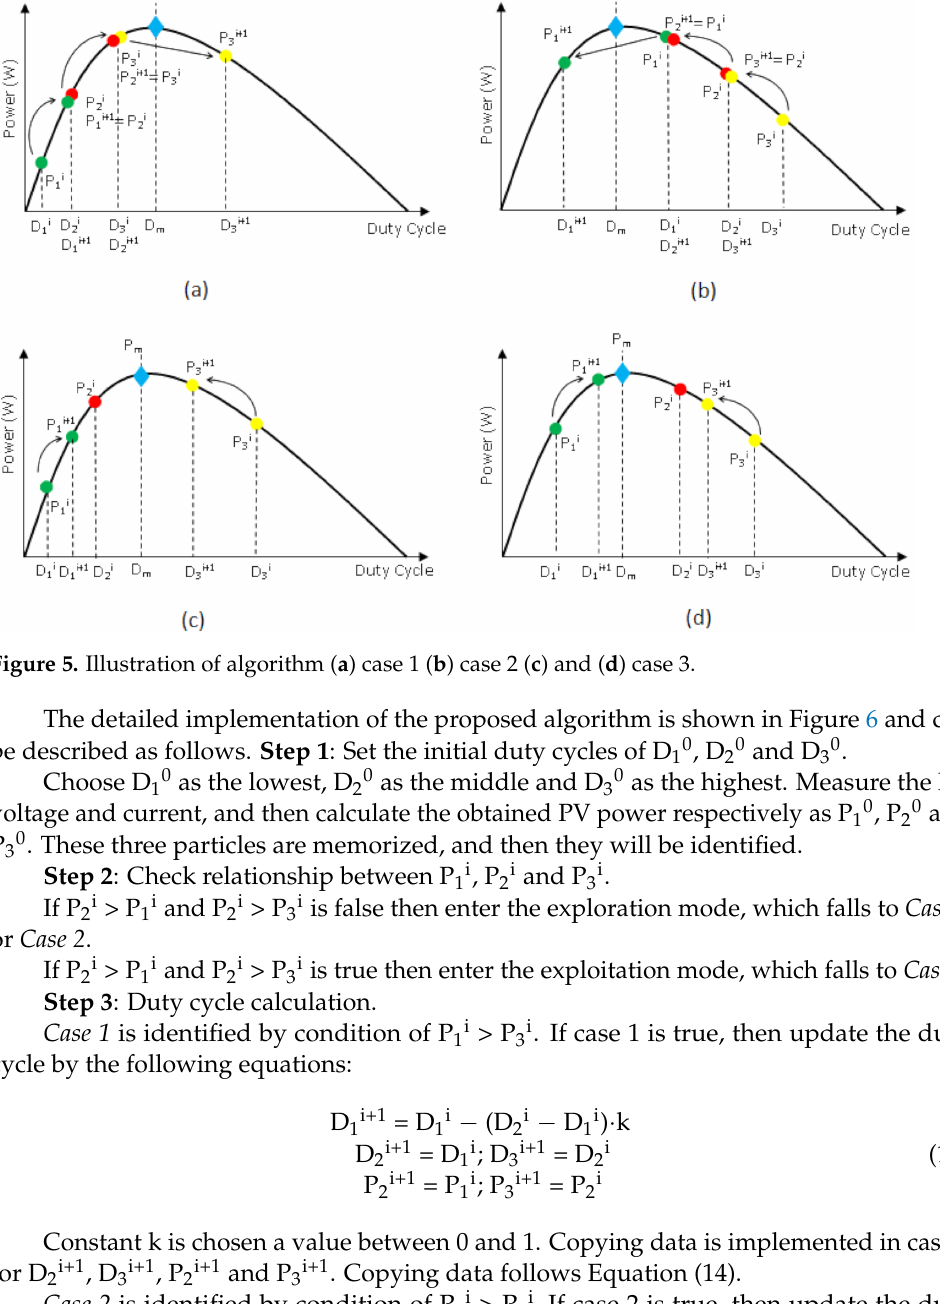
Figure 5c. P 1i and P 3i will approach P 2i . Under certain conditions, P 3i can be higher than